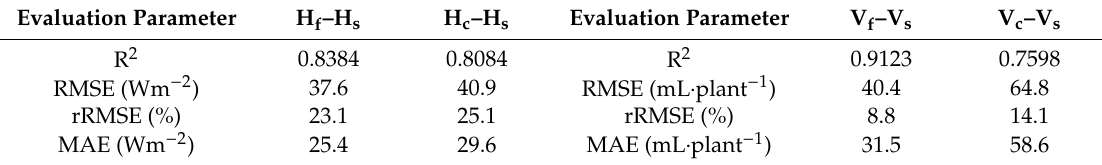
Table 4. Evaluation parameters of solar radiation estimation and tomato water requirement